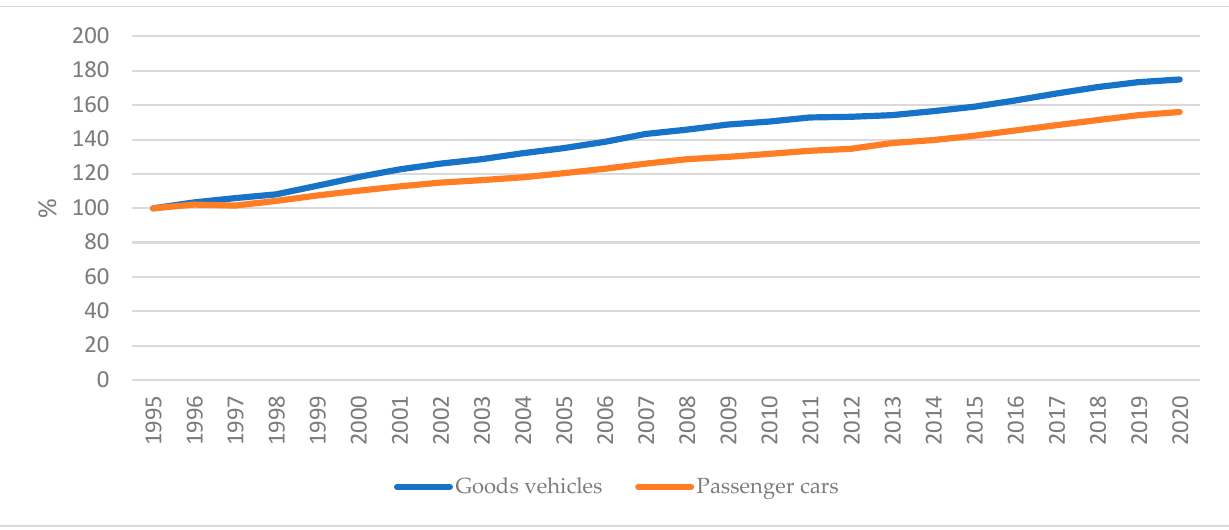
Figure 4. Dynamics of changes in the number of goods vehicles and passenger cars in the EU-27 in the years 1995–2000 (1995 = 100%). Source: Own elaboration based on Eurostat 2022.